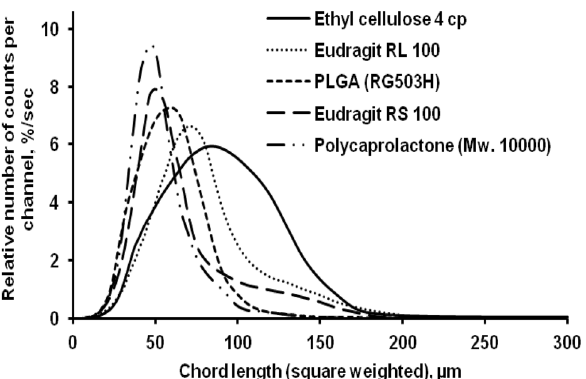
Figure 3. Effect of polymer type on the square weighted chord length distributions, (particle size distribution) at 4 h stirring time.